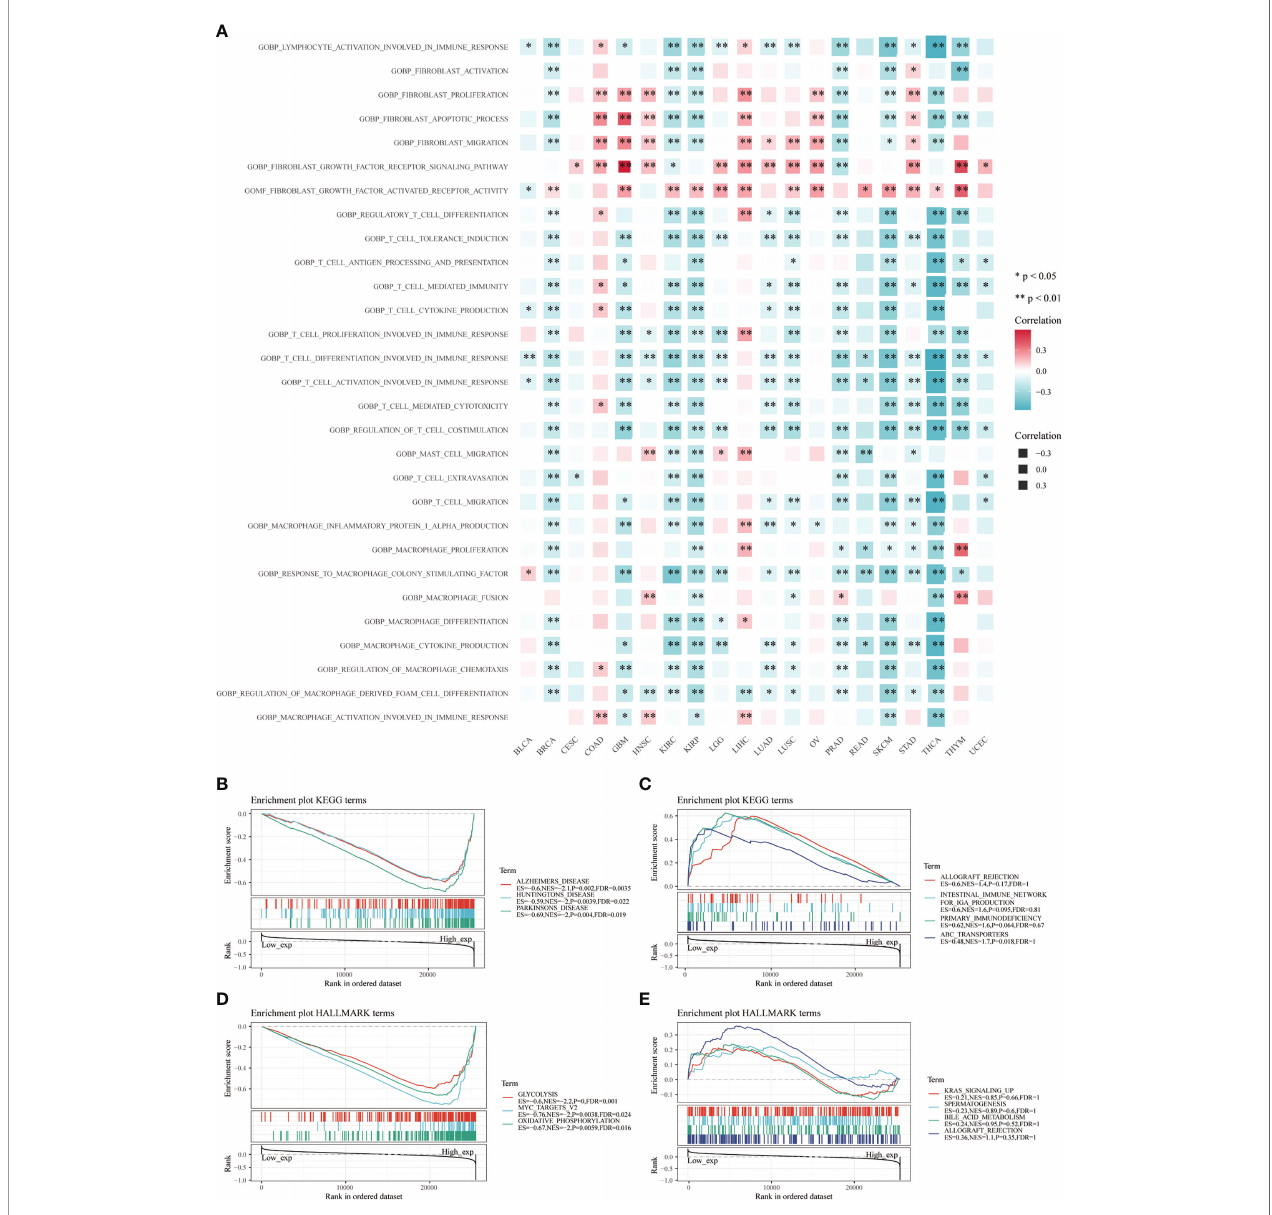
FIGURE 6 | Functional analysis based on CD147 levels in pan-cancer. Functional enrichment pathways of CD147 based on the GSVA algorithm (A) . Top three negative (B) and top four positive (C) enriched pathways based on the KEGG terms. Top three negative (D) and top four positive (E) enriched pathways based on the HALLMARK